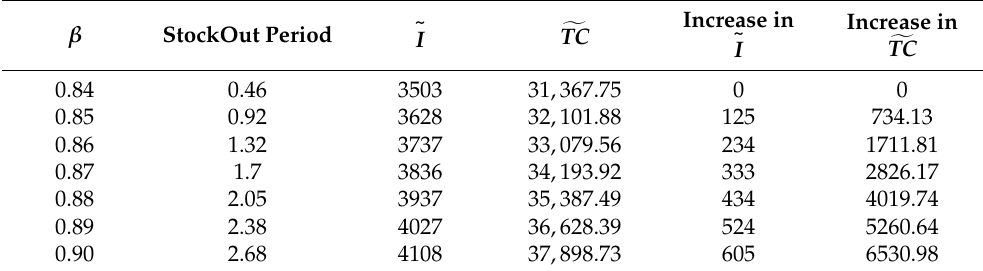
Figure 4. Effect of backlogging rate on optimizing the total cost and ordering quantity.